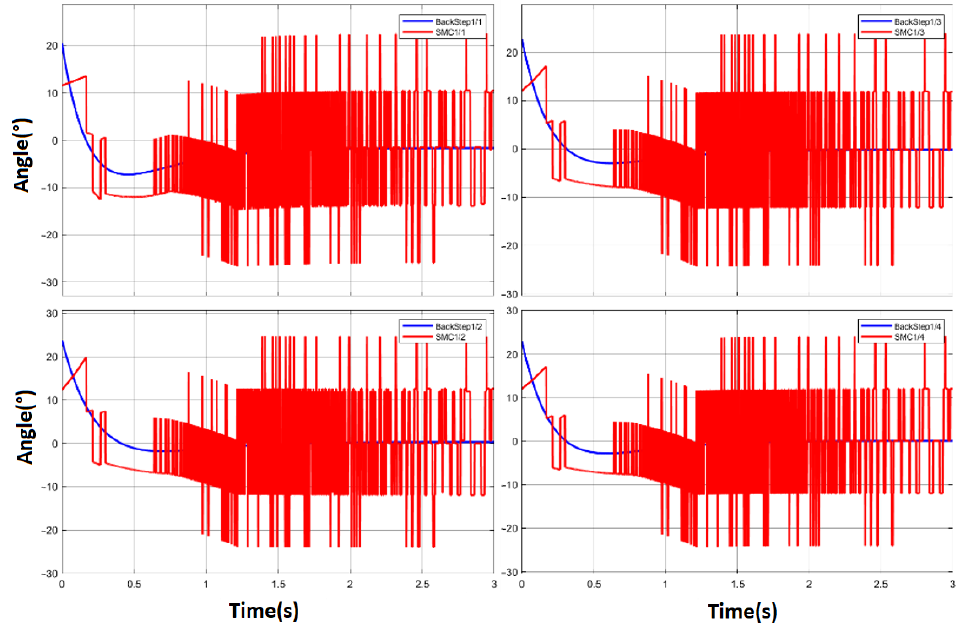
Figure 11. Chattering caused by the SMC control without saturation at 4 DOF of the robotic